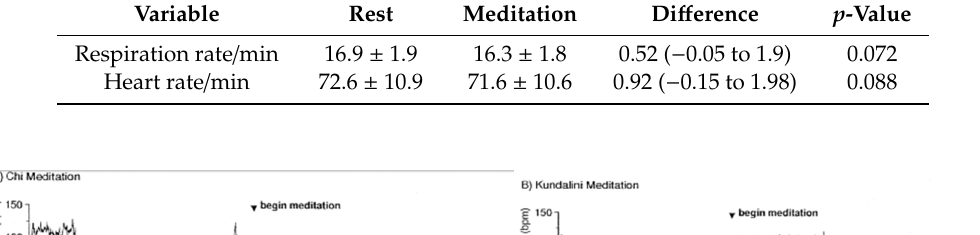
Table 1. Heart rate measures during the Acem meditation technique [4].